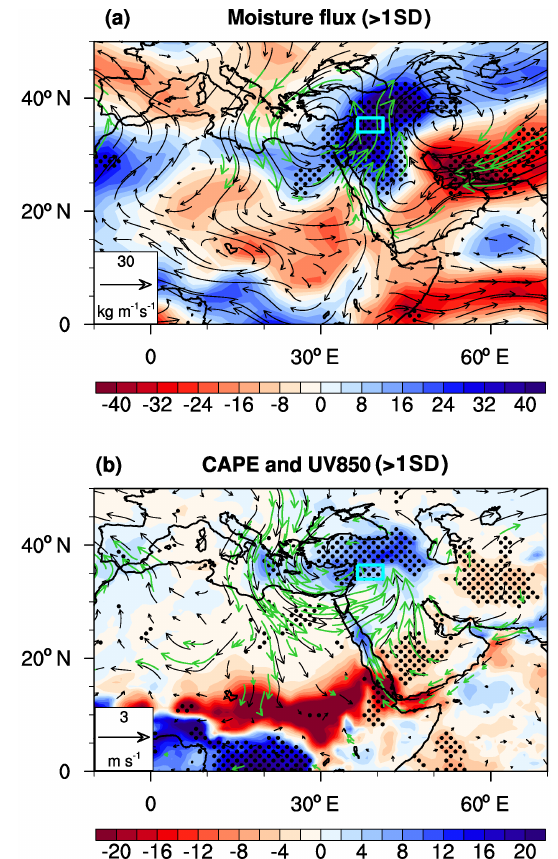
Figure 12. Composites of (a) vertically integrated mass-weighted moisture flux (vectors; kgm − 1 s − 1 ) and its magnitude (shading) from the NCEP1 and (b) CAPE (10Jkg − 1 ) along with 850hPa winds (ms − 1 ) from the ERA-Interim for the days with Syrian DOD index (Aqua) greater than 1 standard deviation during MAM from 2003 to 2015. Moisture flux is integrated from surface to 300hPa. Shading areas significant at the 95% confidence level are